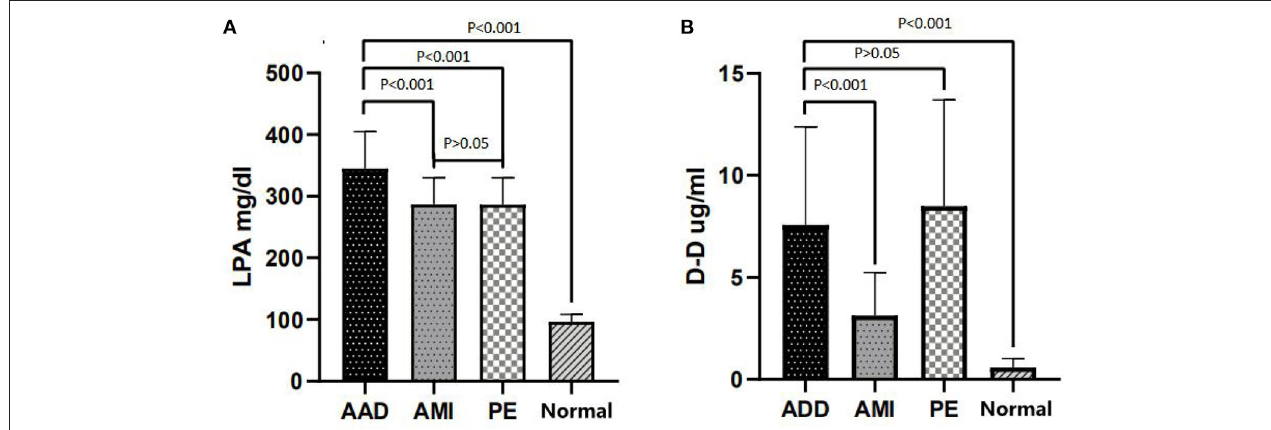
FIGURE 2 | LPA and D-dimer levels in chest pain patients with AAD vs. other groups. (A) LPA distribution (Mean ± standard deviation) in AAD, AMI, PE, and Normal. (B) D-dimer distribution (Mean ± standard deviation) in AAD, AMI, PE, and Normal. LPA, lysophosphatidic acid; AAD, acute aortic dissection; AMI, acute myocardial infarction; PE, pulmonary embolism; Normal, healthy participants.